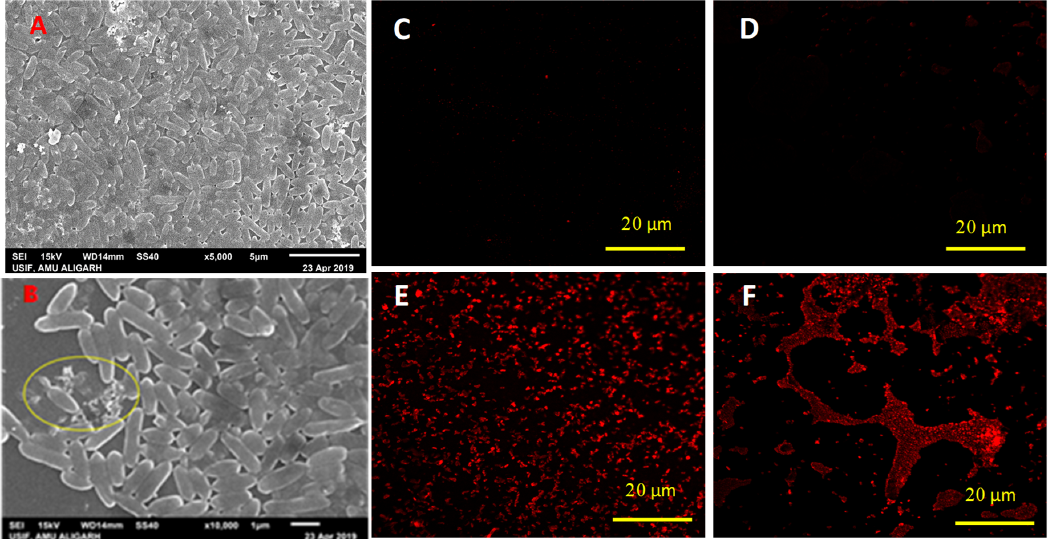
Figure 4. Scanning electron microscopic images of Pseudomonas sp. AZ2. ( A ) untreated / control cells; ( B ) cells treated with 1000 µ g hexaconazole (HEXA) mL − 1 . The yellow circle shows broken /